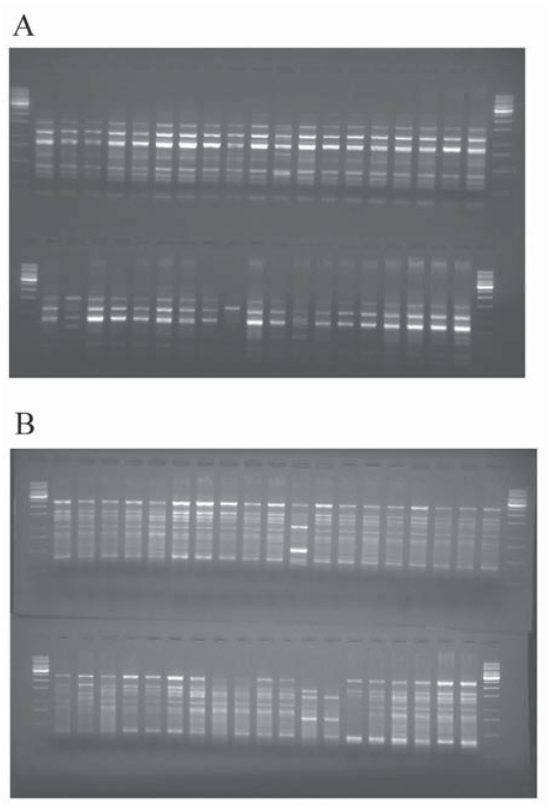
Fig. 2. Gel stained with ethidium bromide showing amplification products generated from the Verticil- lium dahliae isolates with primer OPF-13 (A) and OPF-14